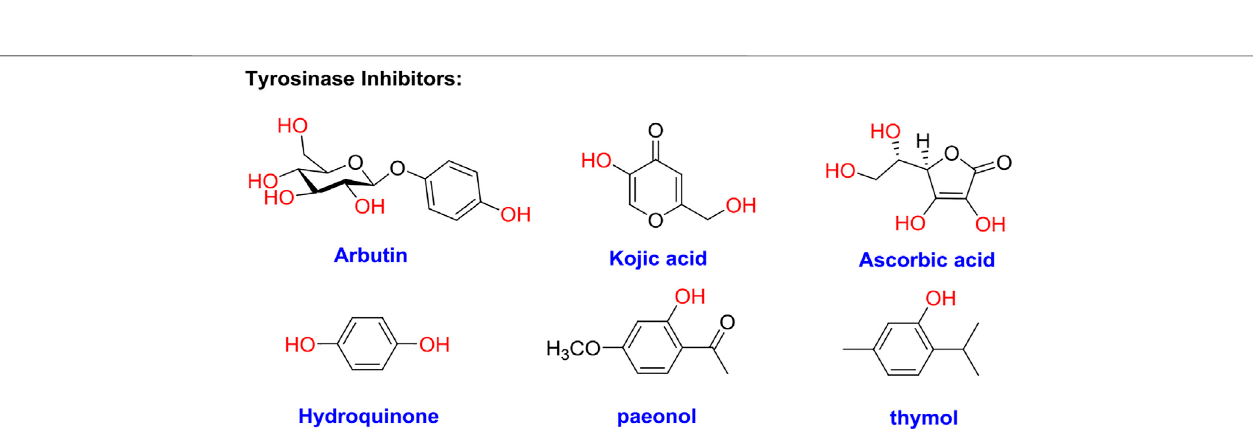
FIGURE 2 | Representative tyrosinase inhibitors.